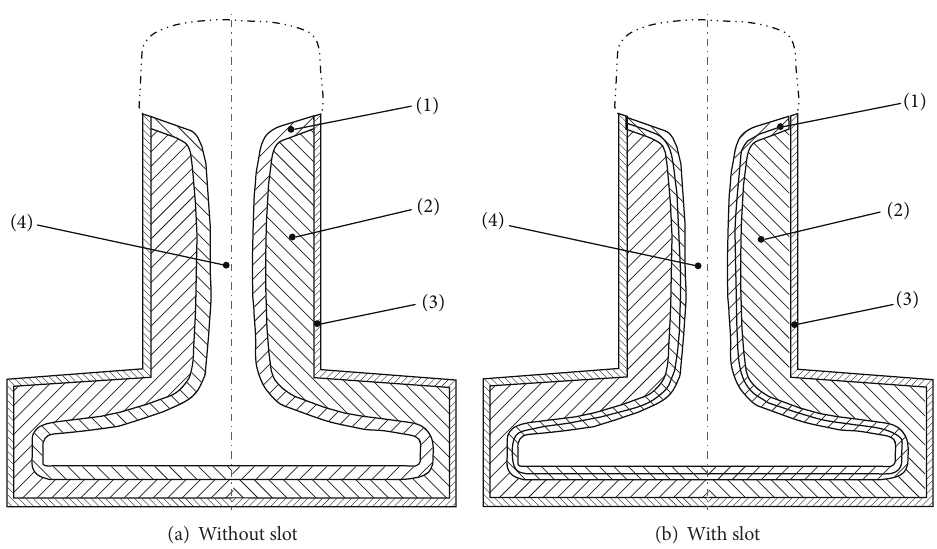
Figure 7: Cross section of the rail with the slotted stand-off layer damping treatment.